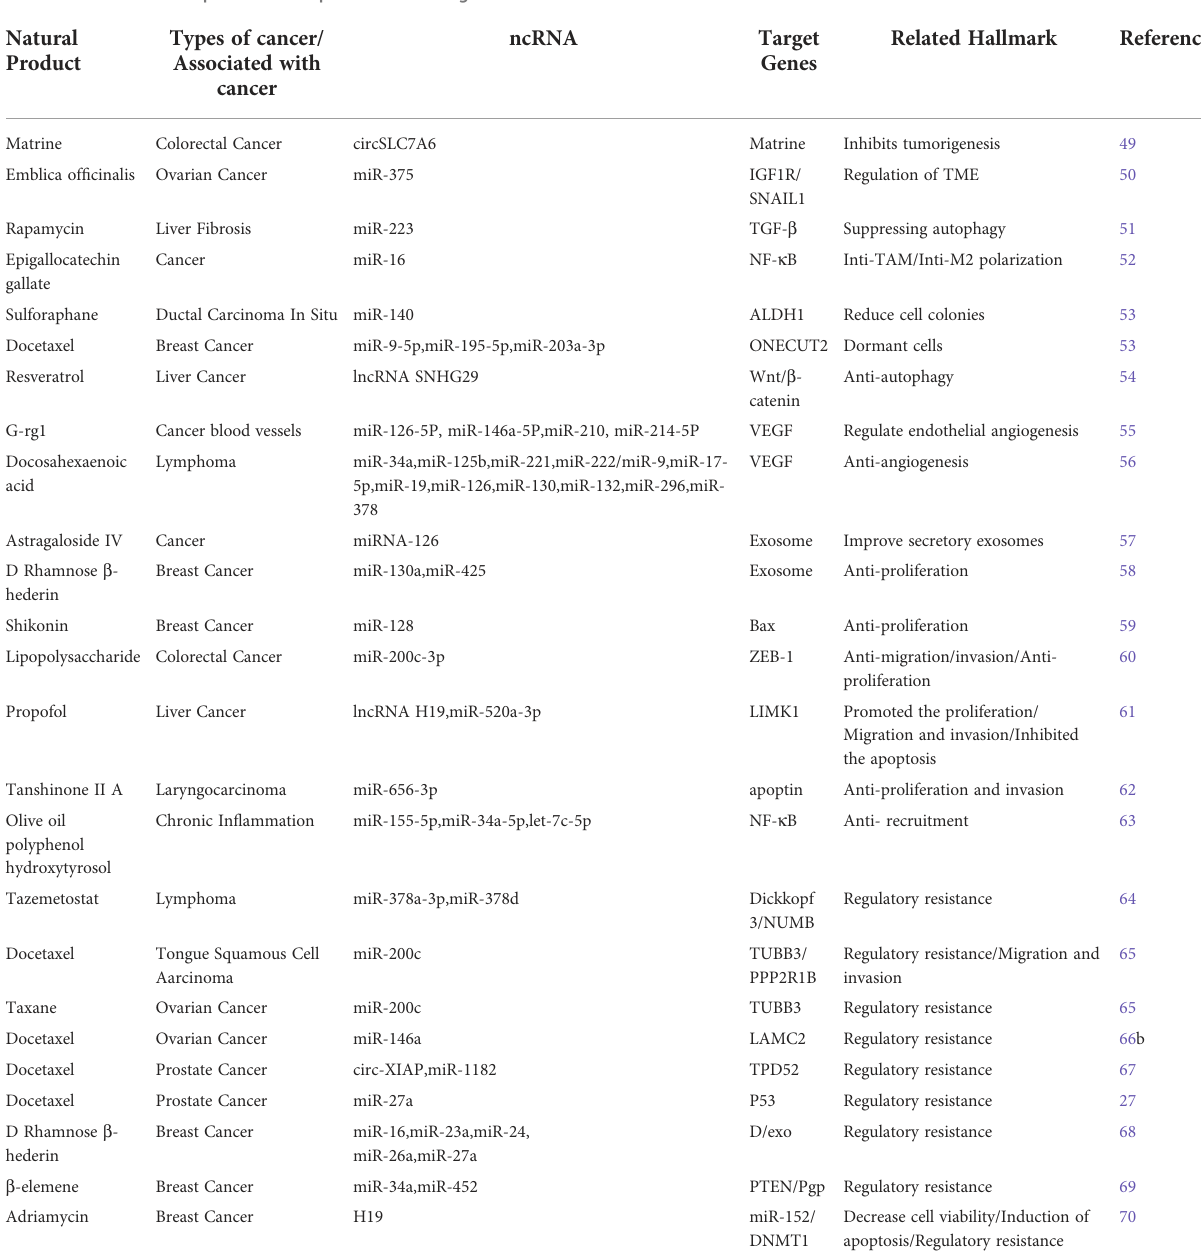
TABLE 1 Detailed example of natural products affecting tumor exosomal